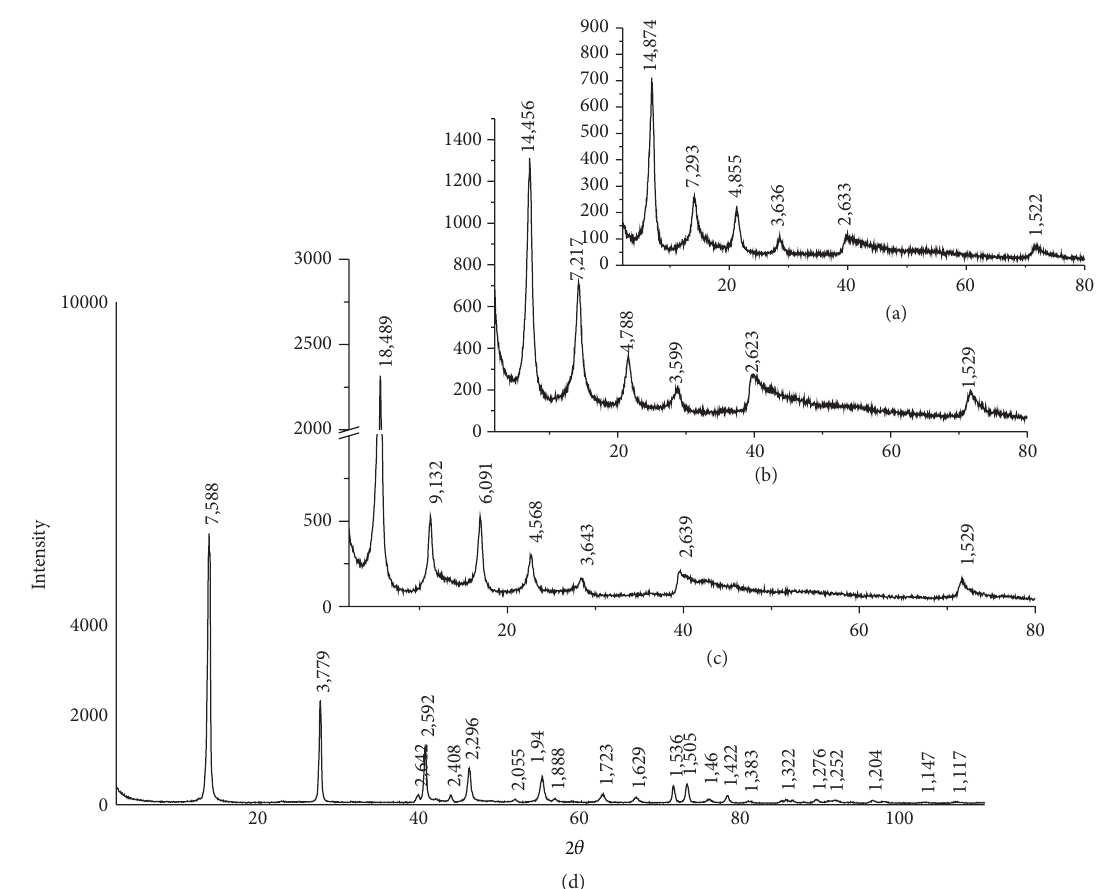
Figure 1: X-ray diffraction images of hydrotalcite adsorbents: (a) Zn,Al-EDTA, (b) Zn,Al-DTPA, (c) Zn,Al-HMDTA, and (d) Zn,Al-CO 3